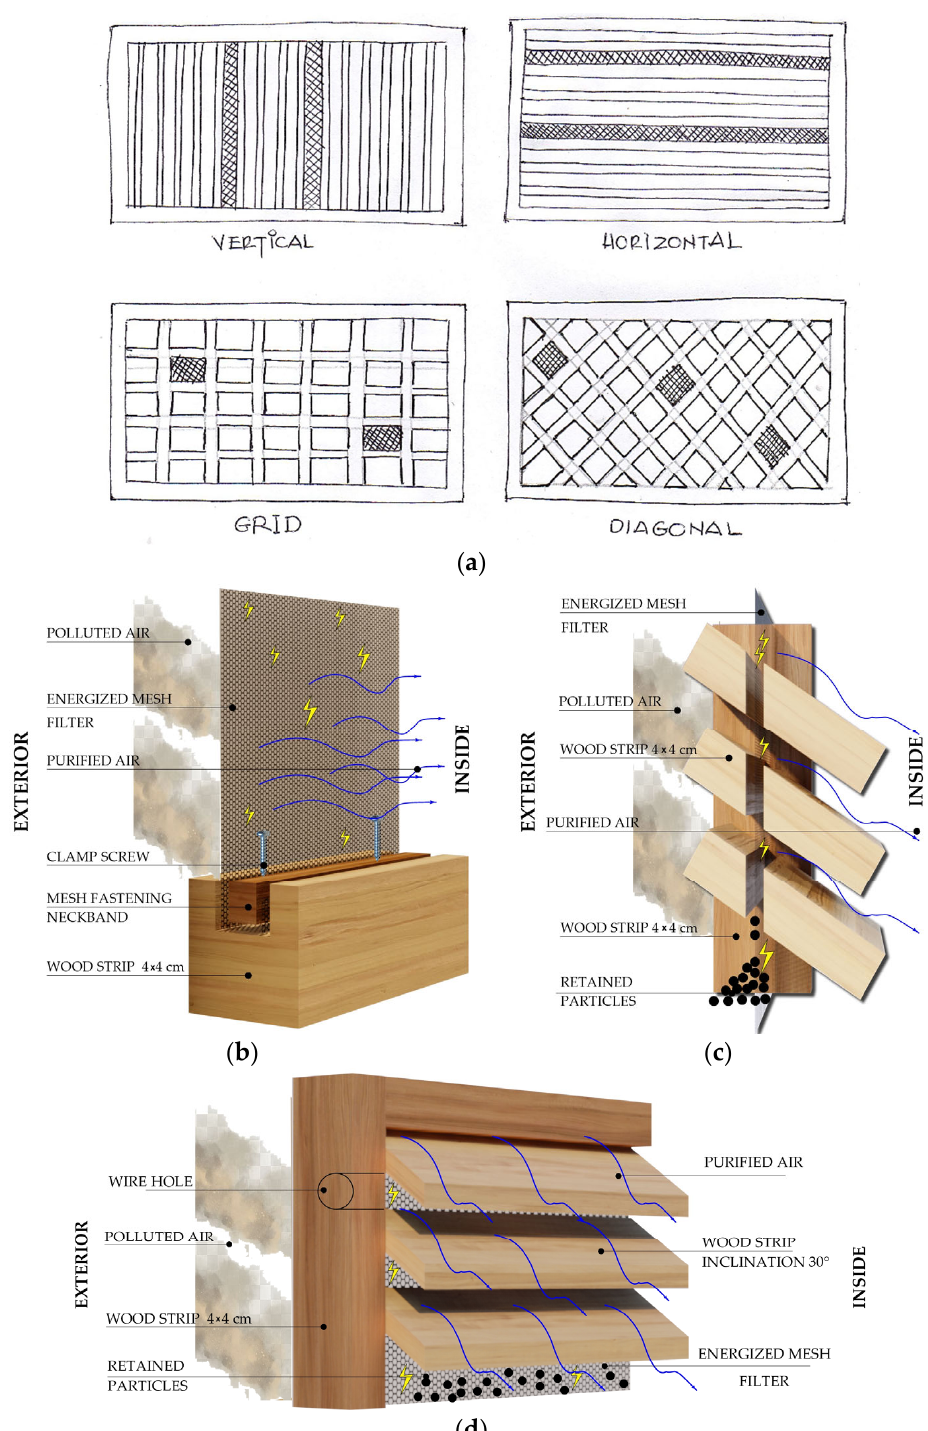
Figure 7. Sketch of the lattice prototype, ( a ) design pattern, ( b ) detail of lath and mesh, ( c ) detail of mesh and wood frame fastening, and ( d ) location of the cable hole for energizing the mesh.